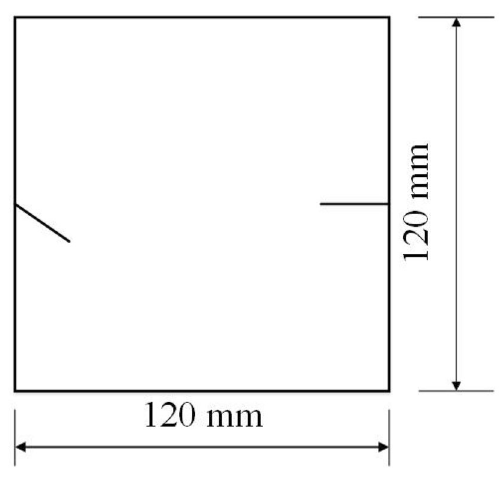
Figure 4. Crack orientation